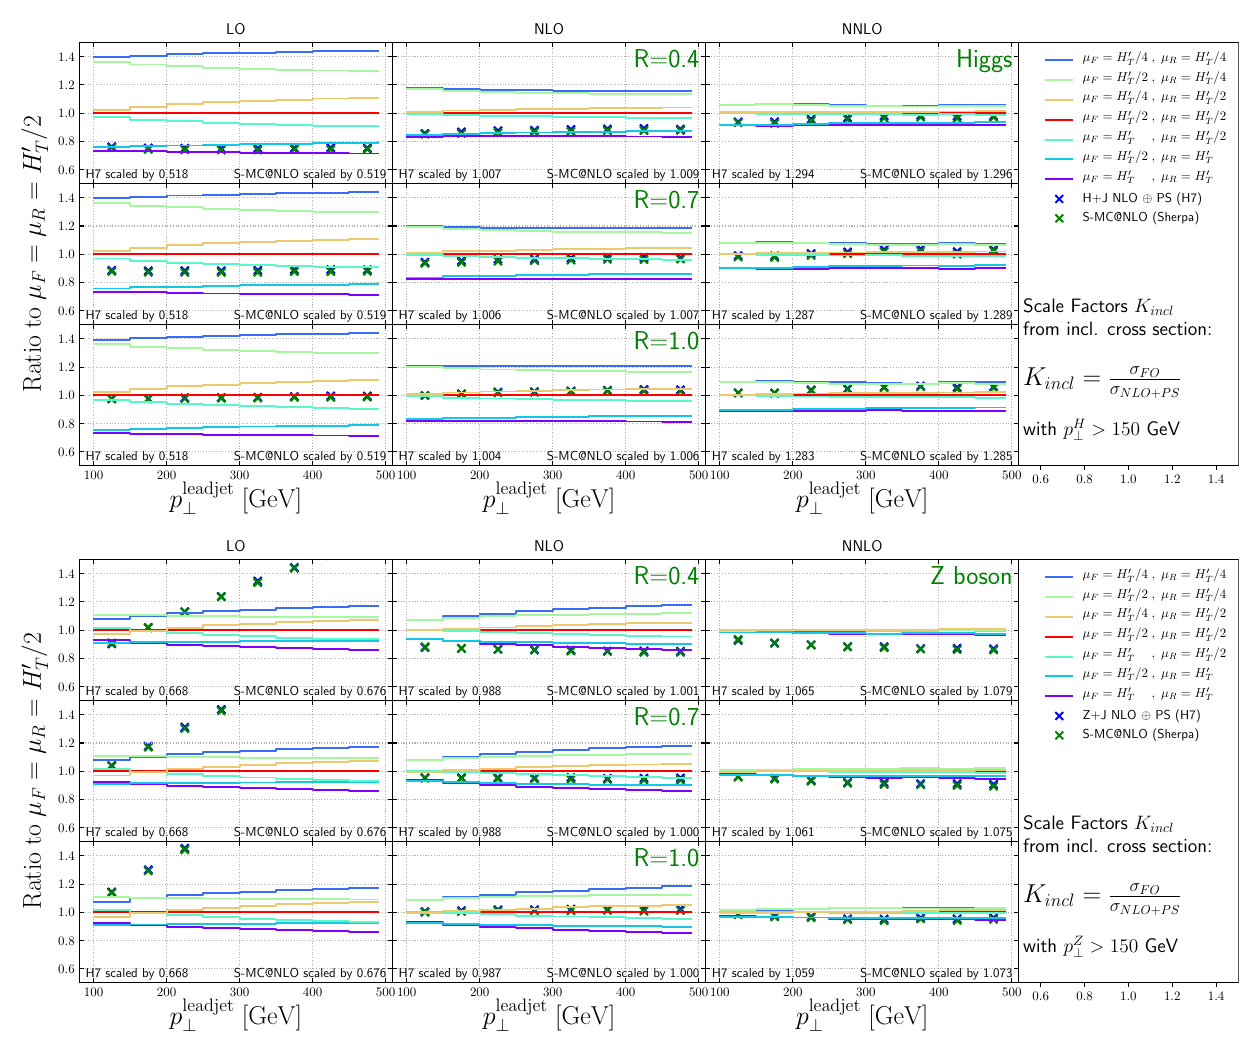
Fig. 6 The scale variations at LO, NLO, and NNLO from NNLOJET for 3 jet sizes, as a function of leading jet transverse momentum, are shown. For comparison, the nominal NLO NLO+PS predictions are